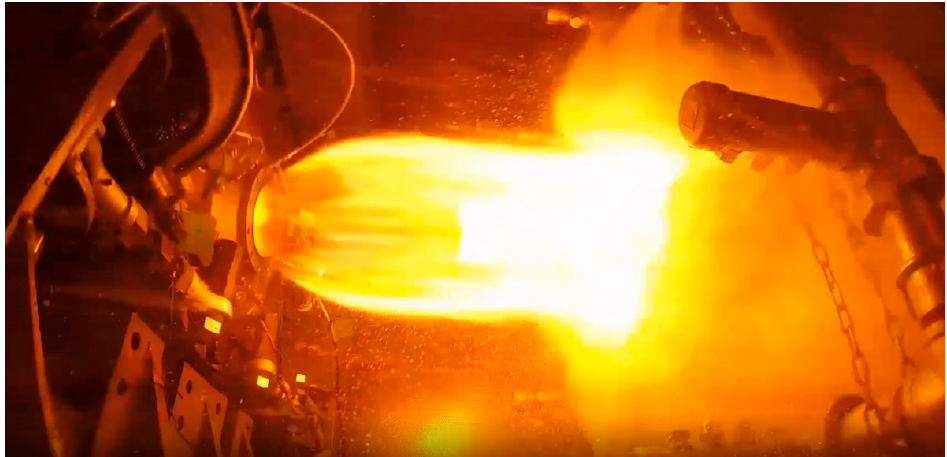
Figure 8. 40 kN motor firing with sound dampening water wall (no nozzle